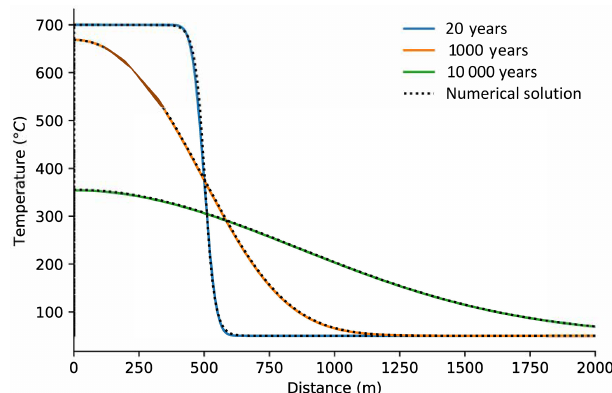
Figure 3. Validation of modelled transient conductive heat flow with an analytical solution (Carslaw and Jaeger, 1959) for the cool- ing of an intrusive over time. Solid lines show calculated tempera- tures using the analytical solution at three different time steps. Bro- ken lines show the numerical solution by Beo.